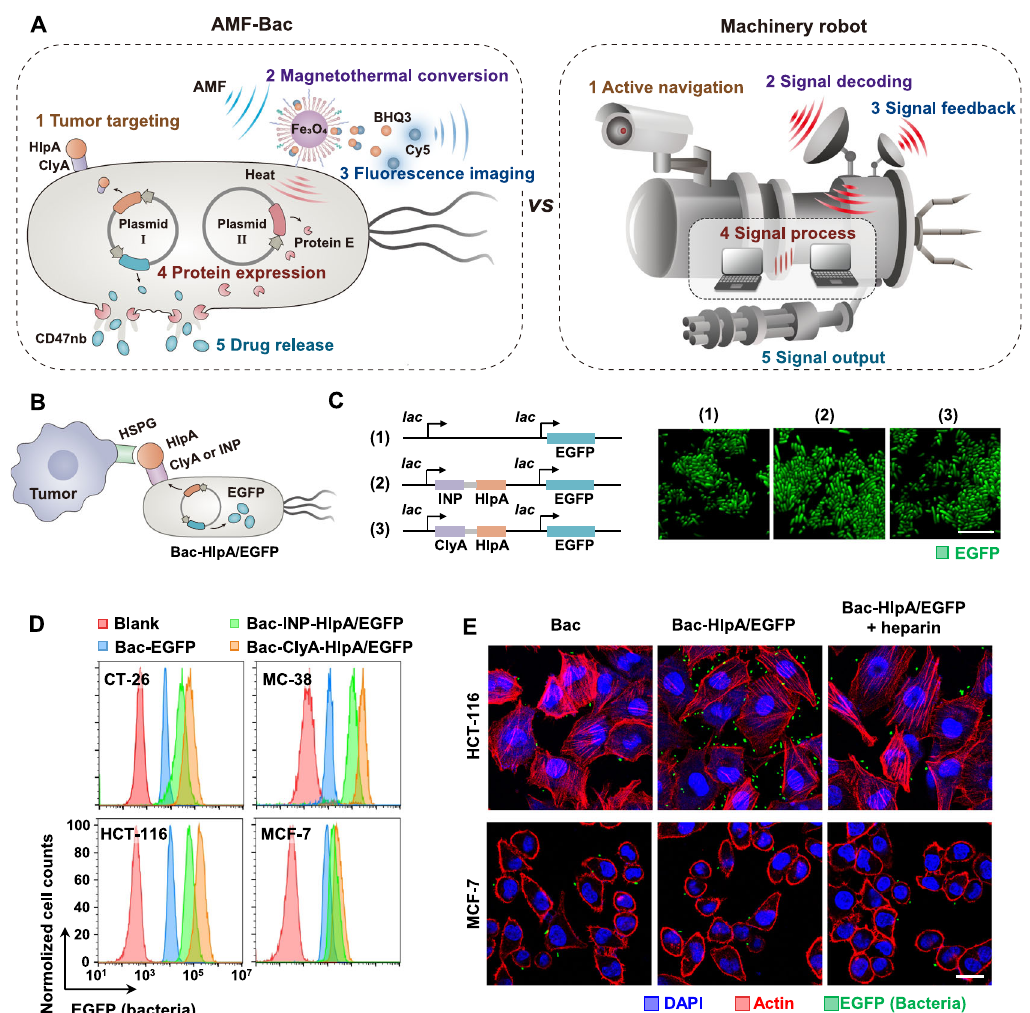
Fig. 1 | Design of AMF-Bac and its analogy with a machinery robot, and the assemblyoftheactivenavigationmodule.A IllustrationofAMF-Bac,comprising fi ve modules: active navigation, signal decoding, signal feedback, signal process, and signal output. The fi ve modules respectively carry out the physiological func- tions of tumor targeting, magnetothermal conversion, fl uorescence imaging, pro- teinexpression,anddrugrelease. B Diagramillustratingthetumor-targetingability of Bac-HlpA/EGFP.HlpAisdisplayed onthe surfaceofBac-HlpA/EGFP fortargeting to the HSPG on colon tumor cells, through two different surface display scaffolds, ClyA and INP. C Expression plasmid design and EGFP expression veri fi cation. Bac- teria were transformed with the indicated plasmids, including pACYC-EGFP (1), pACYC-INP-HlpA-EGFP(2),andpACYC-ClyA-HlpA-EGFP(3),andthecorresponding